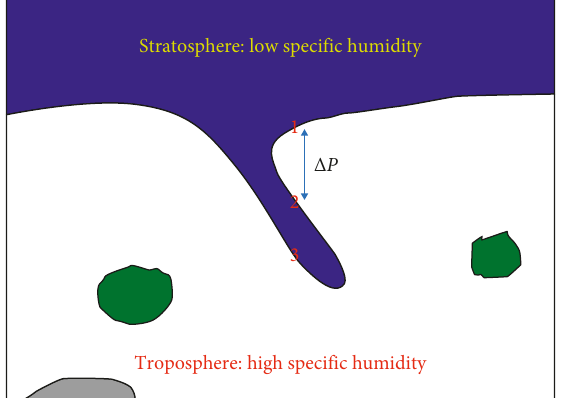
Figure 1: Schematic vertical cross section of the identification of tropopause folds. Stratospheric cutoff or diabatically produced cyclonic PV anomalies are shown by green areas. The gray region is the surface-bond cyclonic PV anomaly. Tropopause folds are de- fined as multiple crossings of the dynamical tropopause in a vertical profile. Δ p is used to classify the